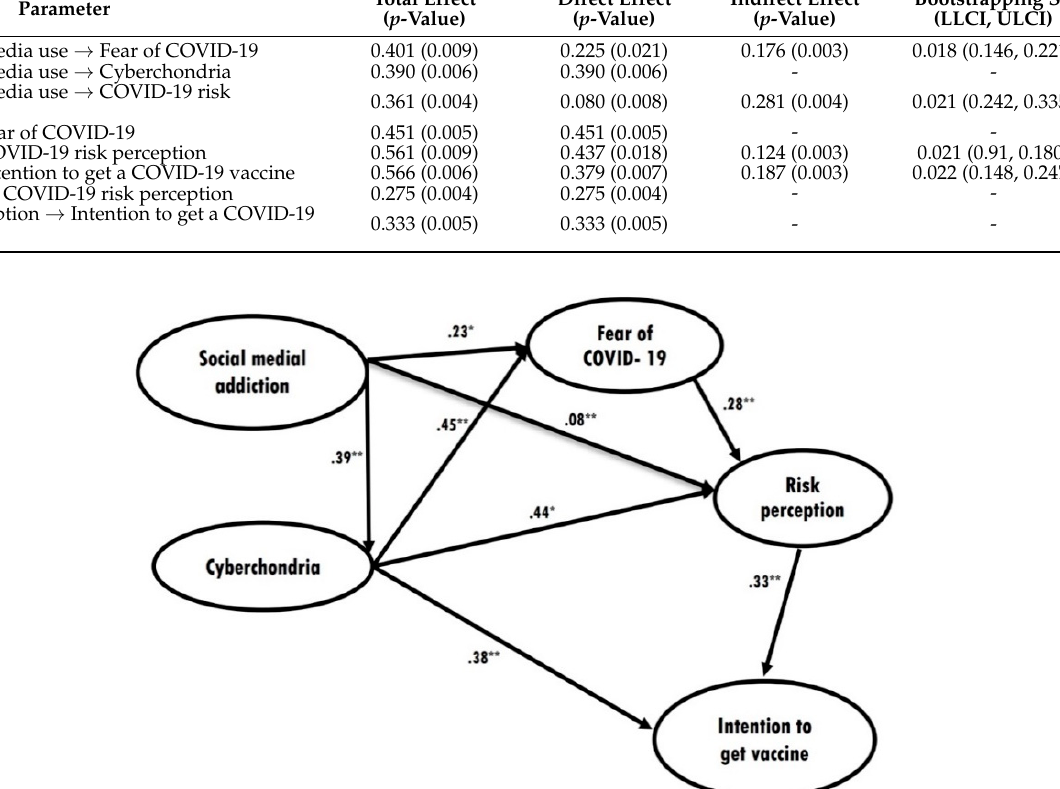
Figure 1. Final structural model of intention to get a COVID-19 vaccine adjusted for age, sex, marital status, education, and area of residence with standardized path coefficients displayed ( χ 2 (df) = 2081.479 (349); p < 0.001). Comparative fit index = 0.969. Tucker–Lewis index = 0.956. RMSEA = 0.060 (0.057–0.062). Standardized root–mean–square residual = 0.0574. * p < 0.05. ** p < 0.01.